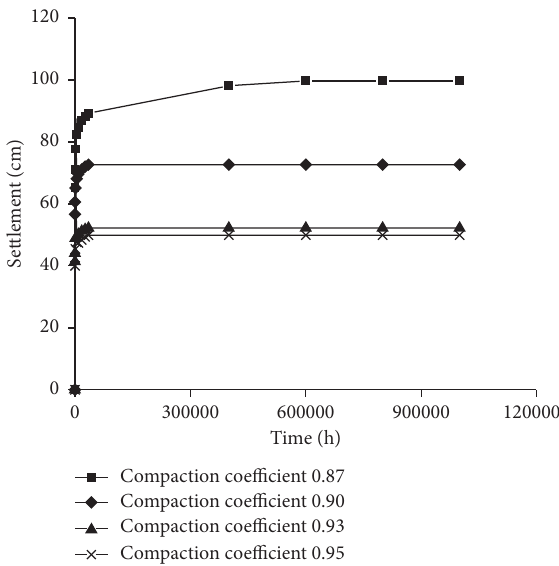
Figure 12: Settlement curves of different compaction coefficients with 30m filling thickness. Table 5: Settlement stability time of loess fill foundation with different compaction coefficients. Compaction